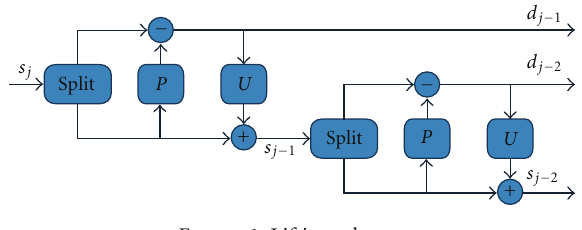
Figure 1: Lifting